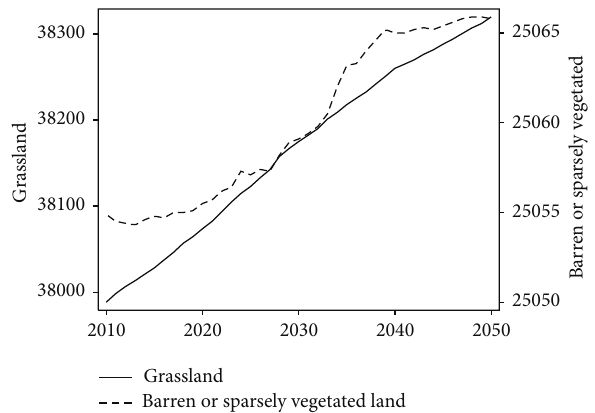
Figure 6: Area changes of grassland and barren or sparsely veg- etated land measured by thousand hectares in Qinghai Province,